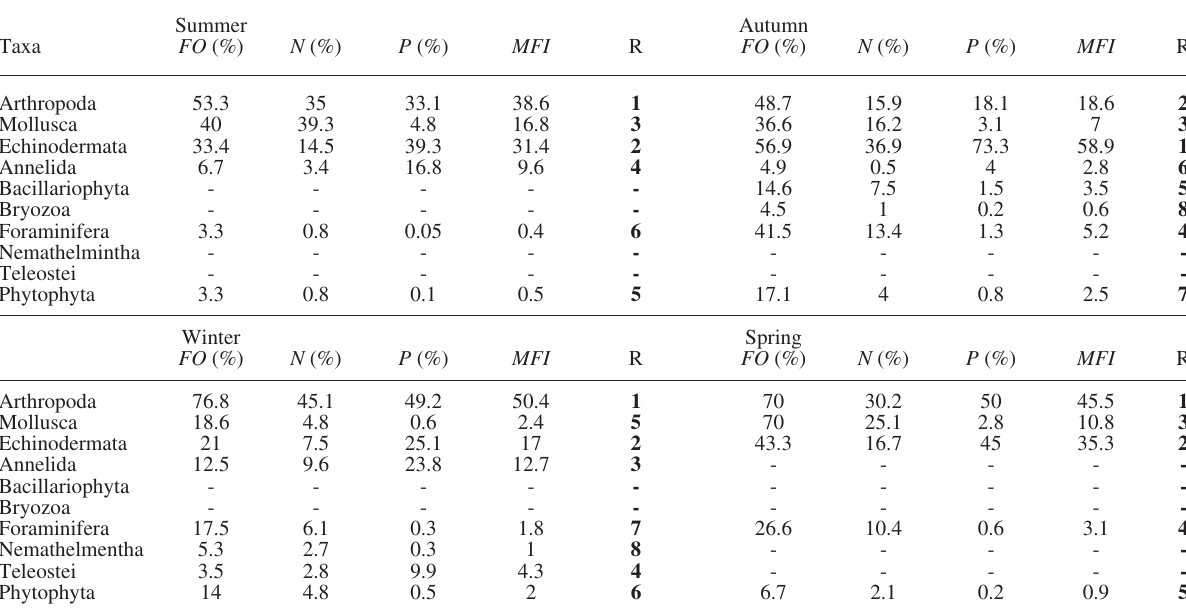
Table 8. – Prey identified in the stomach contents of Pagellus acarne males in relation to season. FO , frequency of occurrence; N , numerical percentage; P , point percentage; MFI , main food index; R, classification of